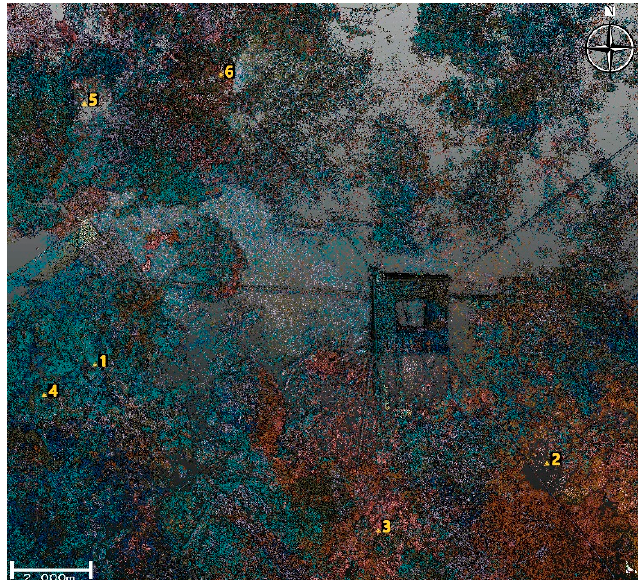
Figure 2. Distribution of the TLS scanning stations.